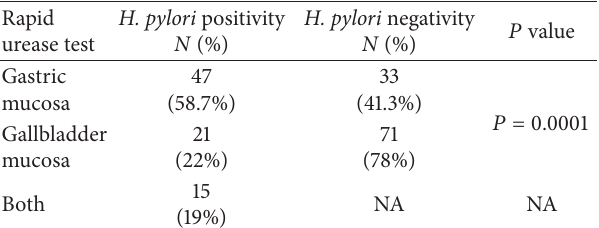
the study (approval number: B.30.2.MAR.0.01.02/AEK/73), and all patients signed the informed consent.